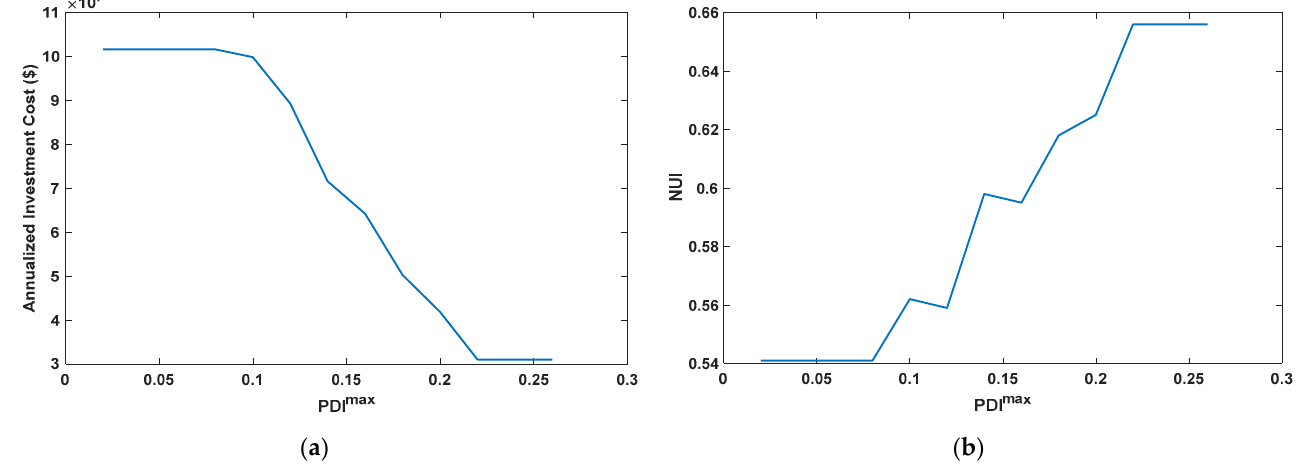
Figure 1. ( a ) Annualized investment cost of transmission lines and ( b ) NUI versus different values of PDI max